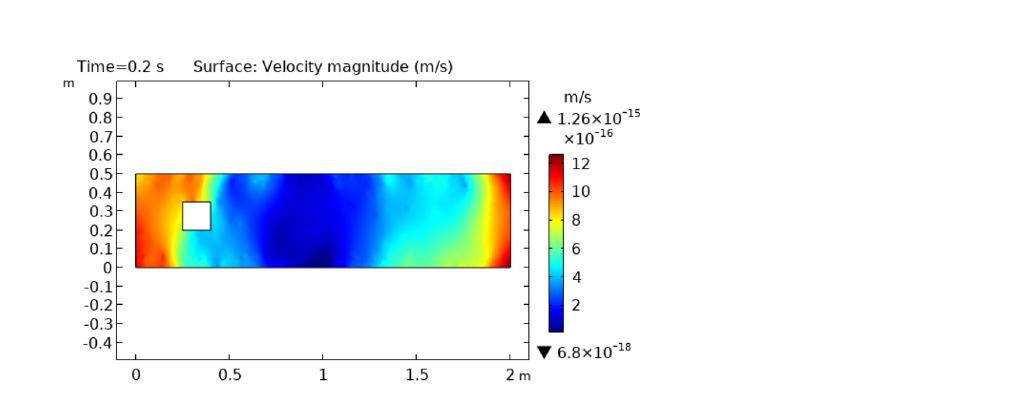
Figure 2. Velocity distribution in squared cylindrical flow at t = 0.2